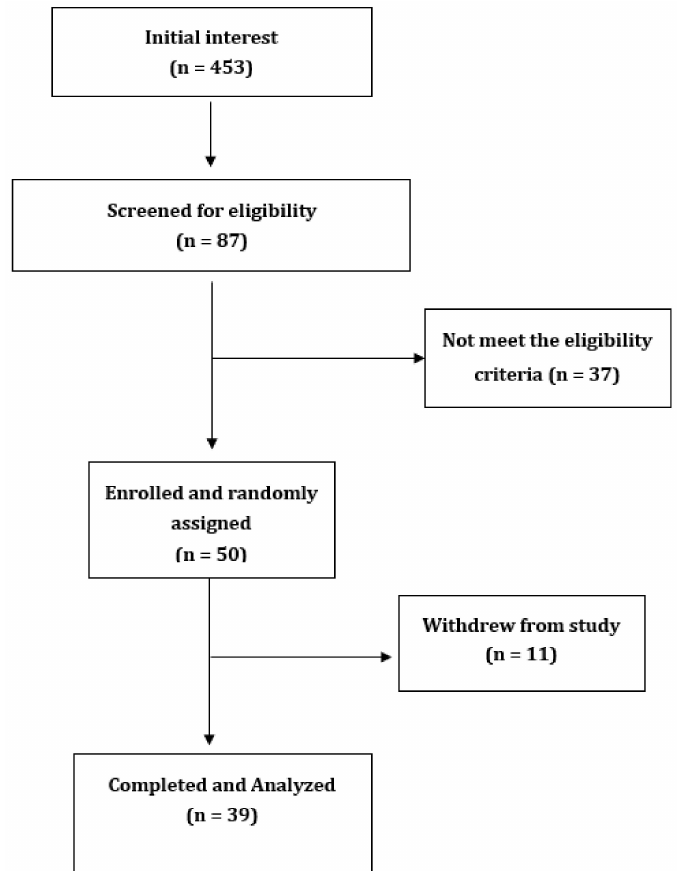
Figure 1. Flowchart of participant recruitment and withdrawal from